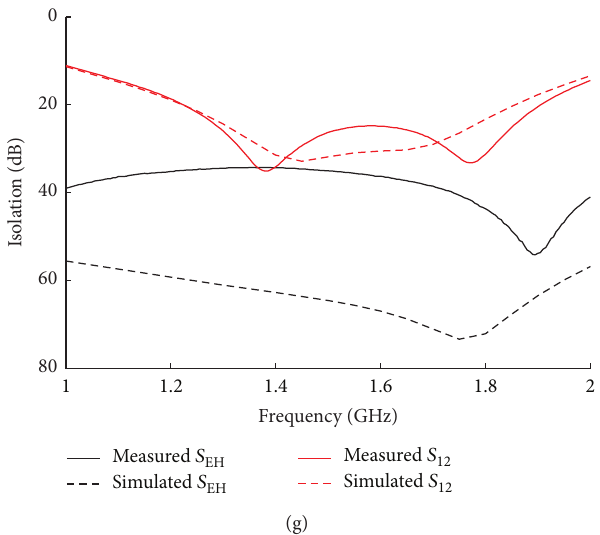
Figure 7: The results of the magic-T. (a) Return loss at port-E and port-H. (b) Return loss at port-1 and port-2. (c) Insertion loss at port-E-1 and port-E-2. (d) Insertion loss at port-H-1 and port-H-2. (e) Amplitude difference. (f) Phase difference. (g) Isolation at ports E-H and 1-2.